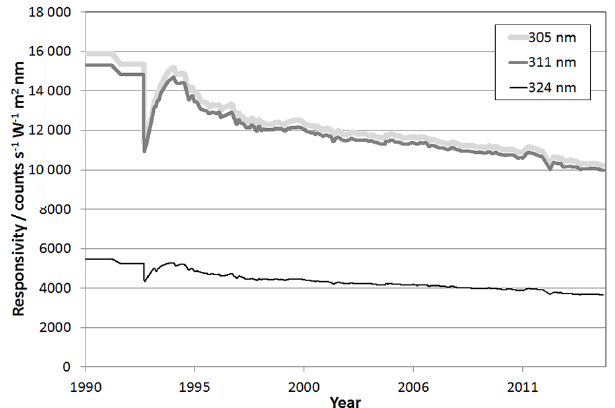
Figure 9. Level2 responsivity of Brewer #037 at different wave- lengths for the time period 1 January 1990–9 December 2015 used for post-processing of solar UV irradiance spectra.